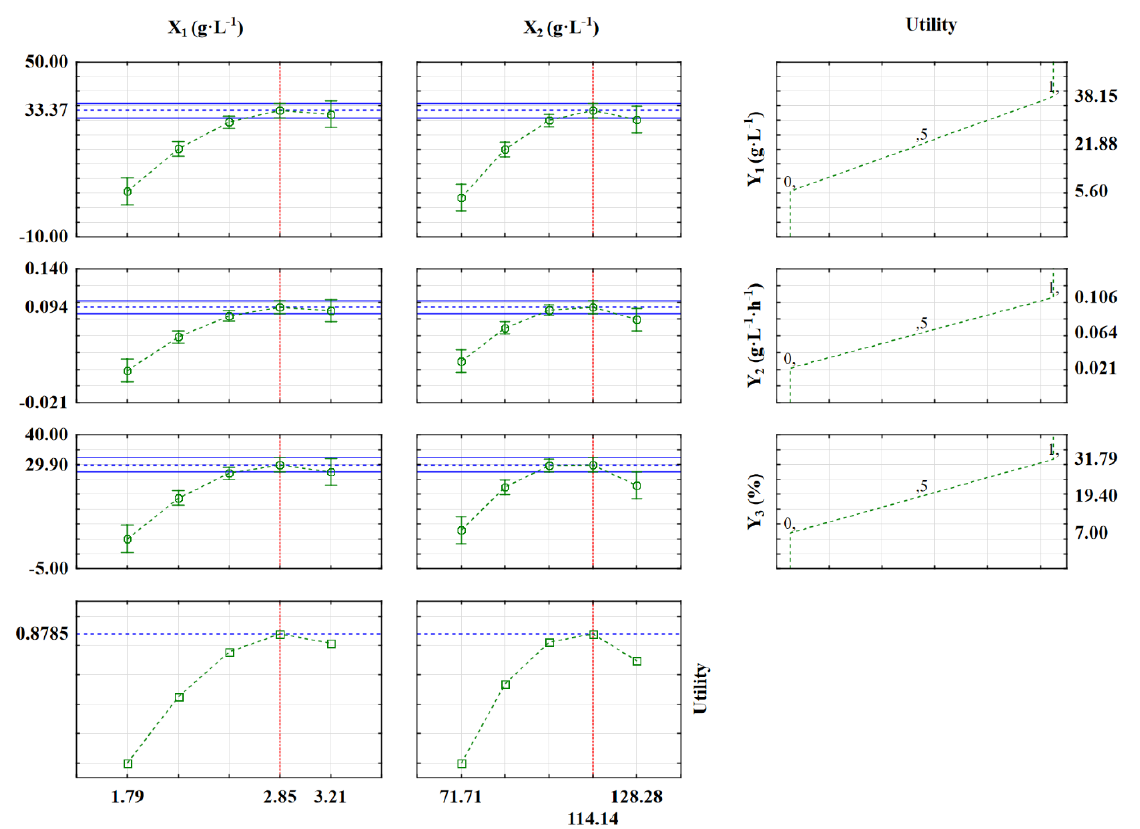
Figure 4. Optimal values utility of the analysed culture medium parameters for the highest final concentration of citric acid (Y 1 ), volumetric rate of citric acid biosynthesis (Y 2 ), and yield of citric acid biosynthesis (Y 3 ). The blue line represents usability. The red line determines the optimal concentrations of the components of the culture medium, waste glycerol and ammonium nitrate. Table 1. Comparison of predicted and experimental response values of verification model.